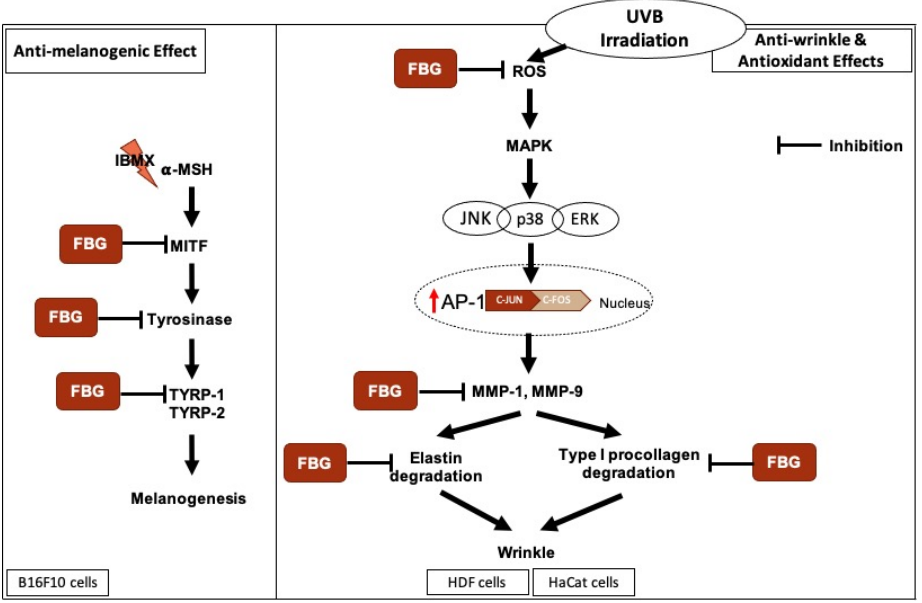
Figure 6. Anti-skin aging mechanism: anti-melanogenic, anti-wrinkle and antioxidant effects of FBG.